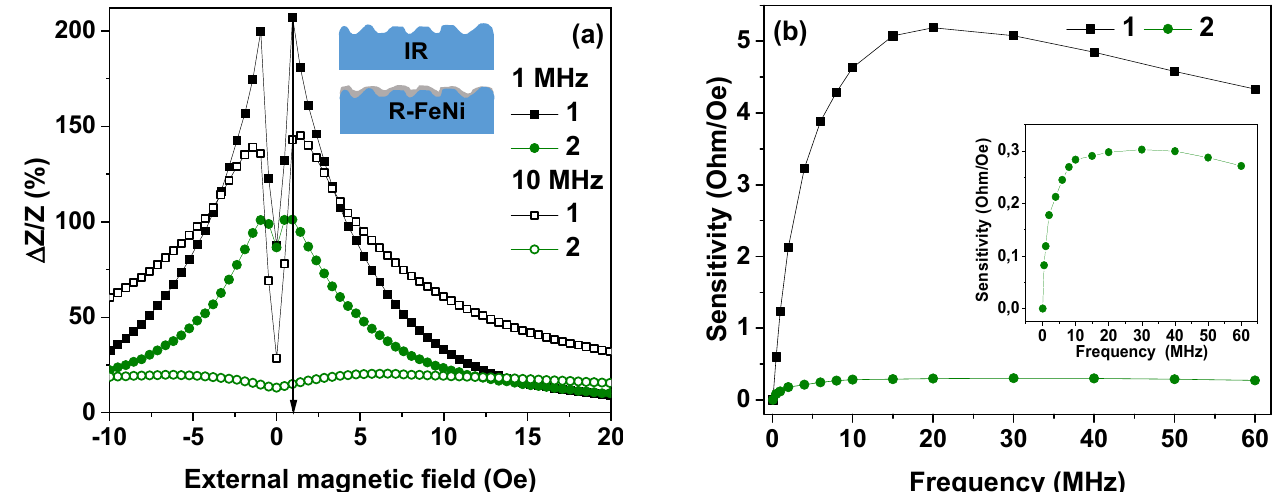
Figure 3. ( a ) Dependencies of the magnetoimpedance ratio on the value of the external magnetic field for different frequencies for the sample IR (black symbols, 1) and for the sample R-FeNi (green symbols, 2). The inset shows the description of the cross section of the IR ribbon and of the ribbon-based R-FeNi composite (not in the real scale) ( b ) Sensitivity dependencies of the MI ratio changes.